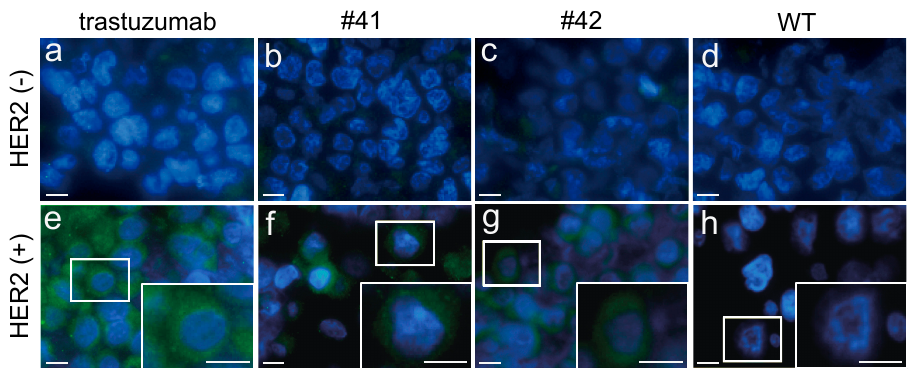
Figure 6. HER2 ‐ specific binding of the mAbs deposited in KI egg whites. Sections of HER2 ‐ negative (HER2( − ), ( a – d ) and positive (HER2(+), ( e – h ) cells were treated with trastuzumab ( a , e ), KI egg whites from chicken #41 ( b , f ) and chicken #42 ( c , g ) and WT egg whites ( d , h ), subsequently examined using immunofluorescence. The expression of HER2 was visualized using an Alexa Fluor 488 ‐ conjugated tertiary antibody (Green). The cell nuclei were counterstained with DAPI. Enlarged insets of HER2 ‐ positive cells are shown in ( e – h ). The scale bar represents 10 μ m.